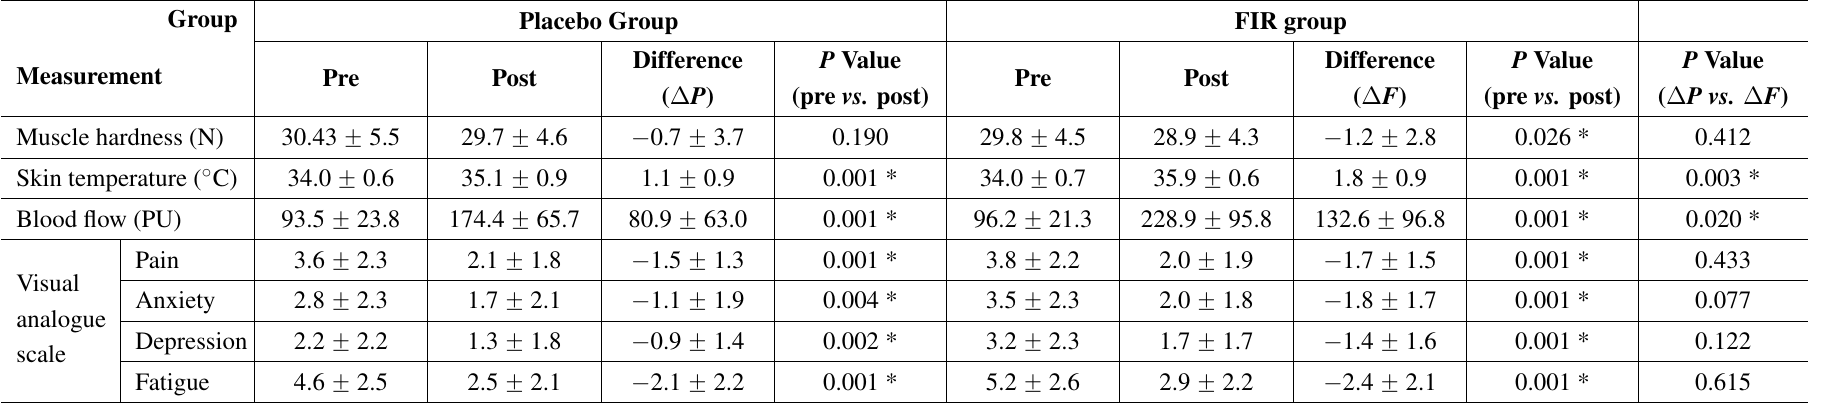
Table 1. Comparison of measured results in the control group and the intervention